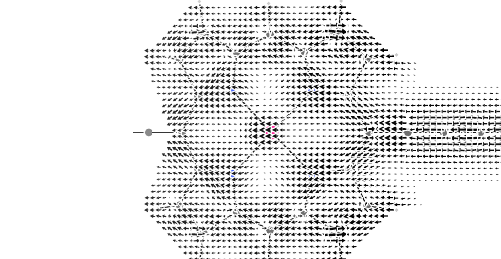
shape. The magnetic field is directed upwards and the point of view is in the center of the nanoring, so that paratropic (diatropic) currents are directed towards the left (right).